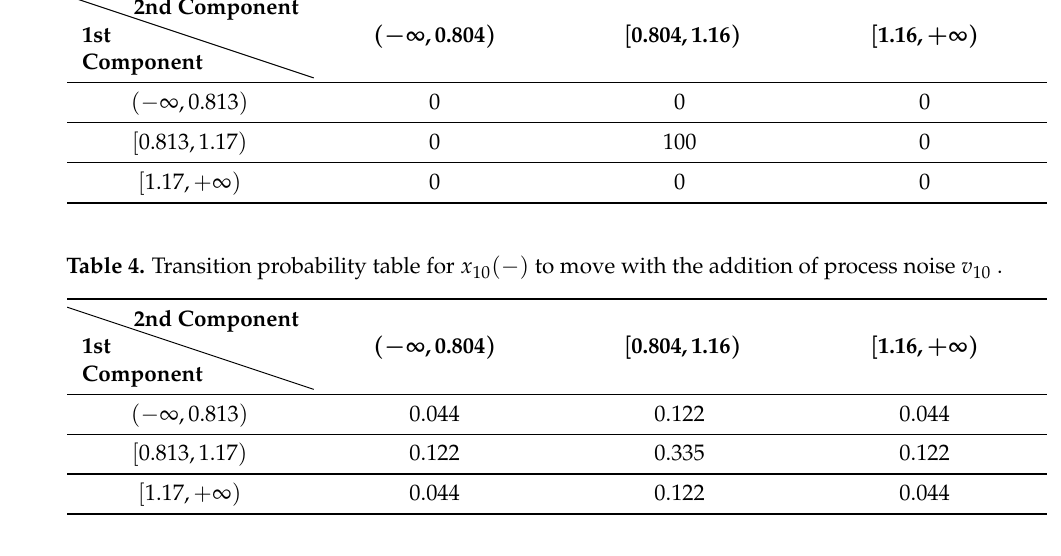
Table 5. Frequency table for the expected numbers of the particles over the grid cells after the addition of process noise realizations at t =